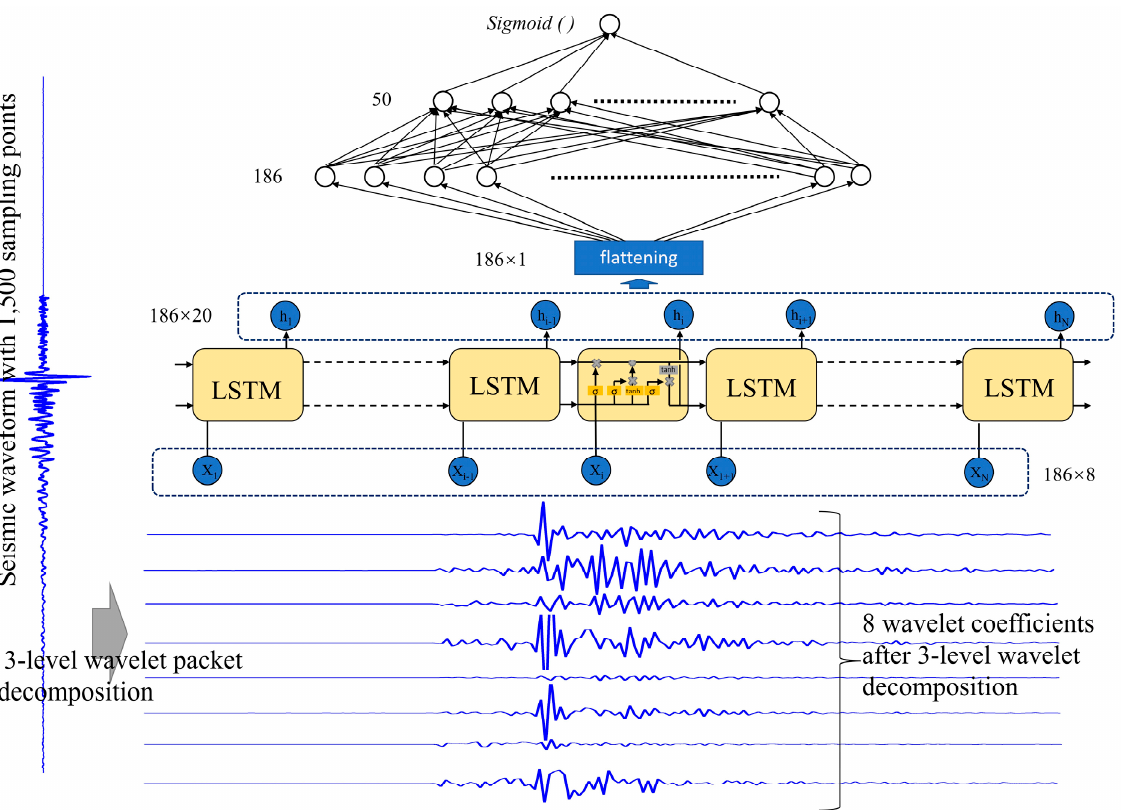
Figure 7. Automatic seismic P arrival picking using wavelet packet decomposition and deep learn- ing. After performing a 3-level wavelet packet decomposition, the eight wavelet coefficients can be obtained from the seismic waveform. These wavelet coefficients are adopted as input for the train- ing of the LSTM network.